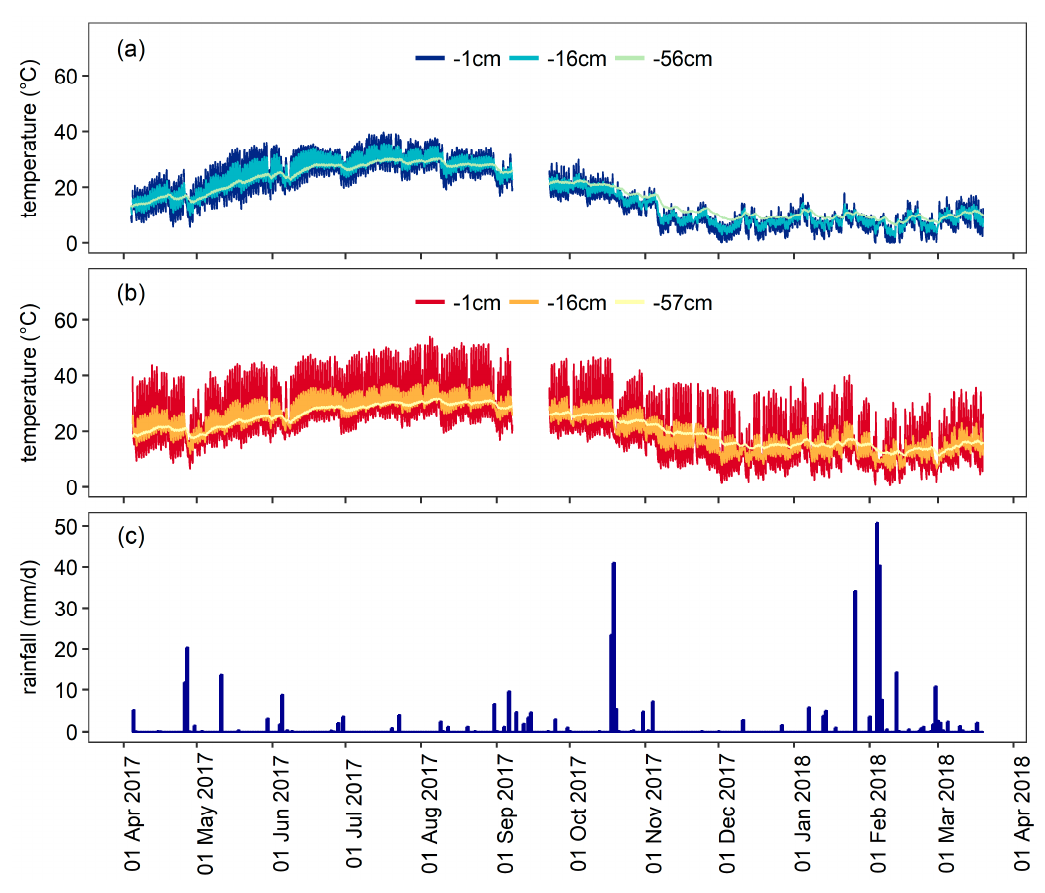
Figure 10. Soil temperature of the complete time series registered at the full-scale experiment. ( a ) North slope without vegetation; ( b ) South slope without vegetation; ( c ) daily rainfall.